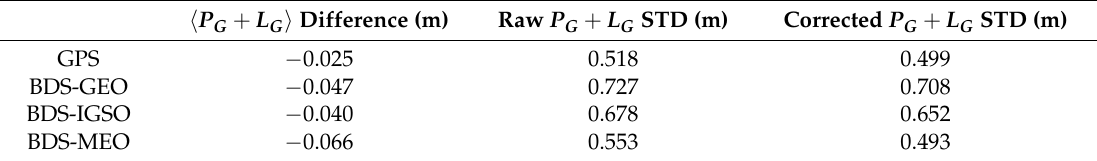
Figure 2. C14 leveled carrier-to-code ionospheric observation variations during DOY 062/2015. The red lines show the original series while the blue with multipath correction applied; the grey line is the elevation. The average of the leveled carrier-to-code ionospheric observation series is subtracted. Table 1. Statistics of (cid:104) P G + L G (cid:105) average differences between leveled carrier-to-code observables with and without multipath errors corrected and the STD improvement. All the arcs in DOY 062/2015 are taken into account and the values are averaged for GPS, BDS GEOs, BDS IGSOs and BDS MEOs.